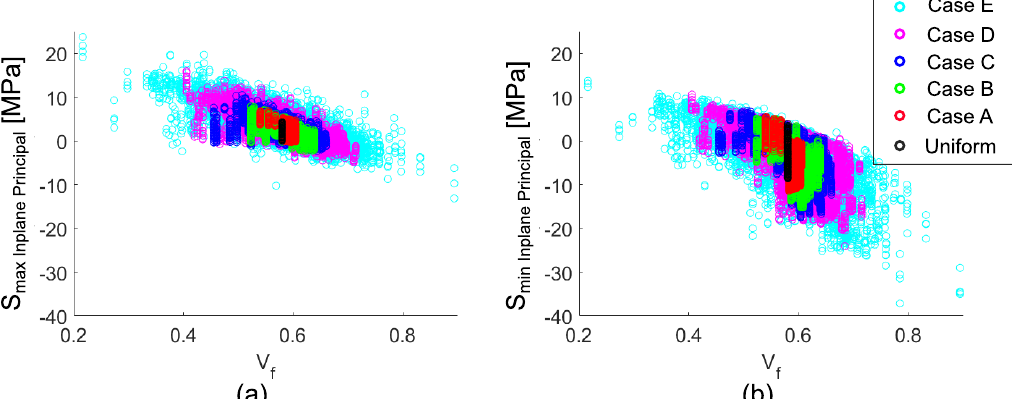
Figure 10. Scatter plots of the in-plane principal stresses with respect to V f for each patch size cases; ( a ) maximum in-plane stress, ( b ) minimum in-plane